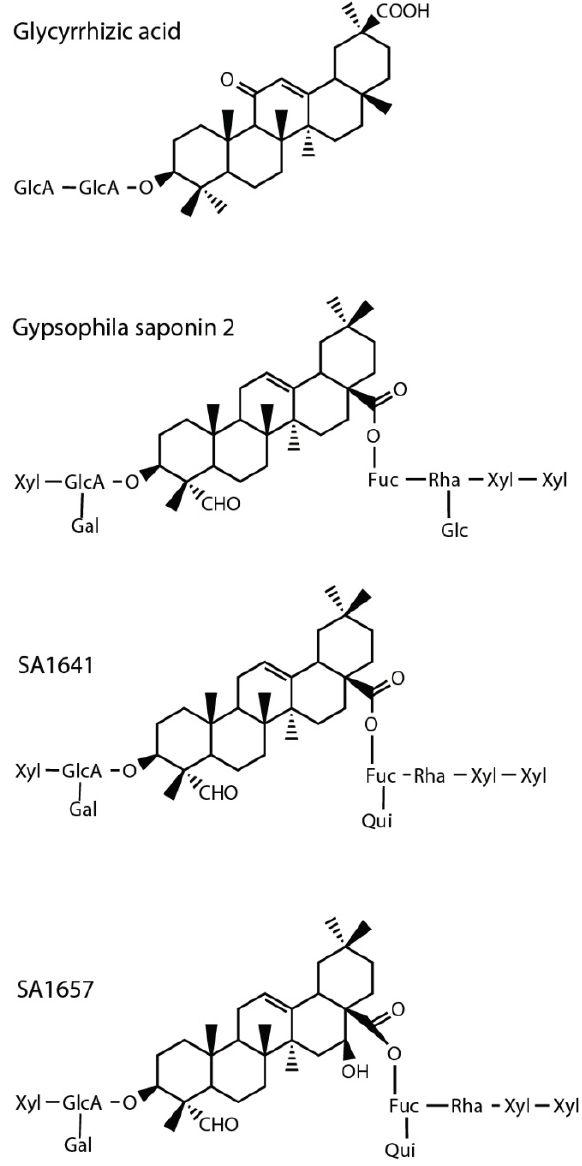
Figure 8. Compounds tested on inhibition of Hyal-1 of displayed on the surface of E. coli F470. The abbreviations Fuc (fucose), Gal (galactose), GlcA (glucuronic acid), Glc (glucose), Qui (chinovose), Rha (Rhamnose), Xyl (xylose) stand for different sugar